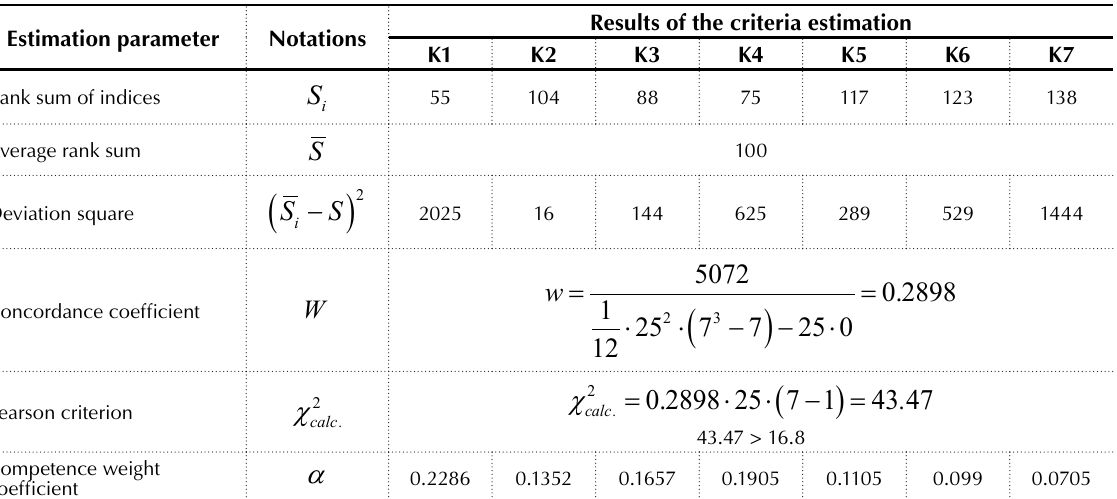
Table 1. Results of the criteria ranking for choosing strategic direction for the research organization development